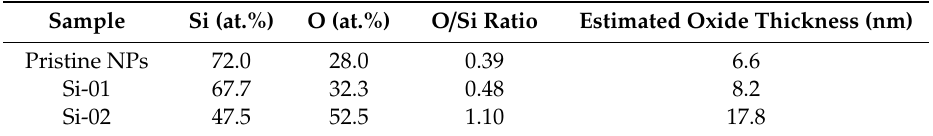
Table 2. A relative content of silicon and oxygen content in the measured samples obtained by EDX.